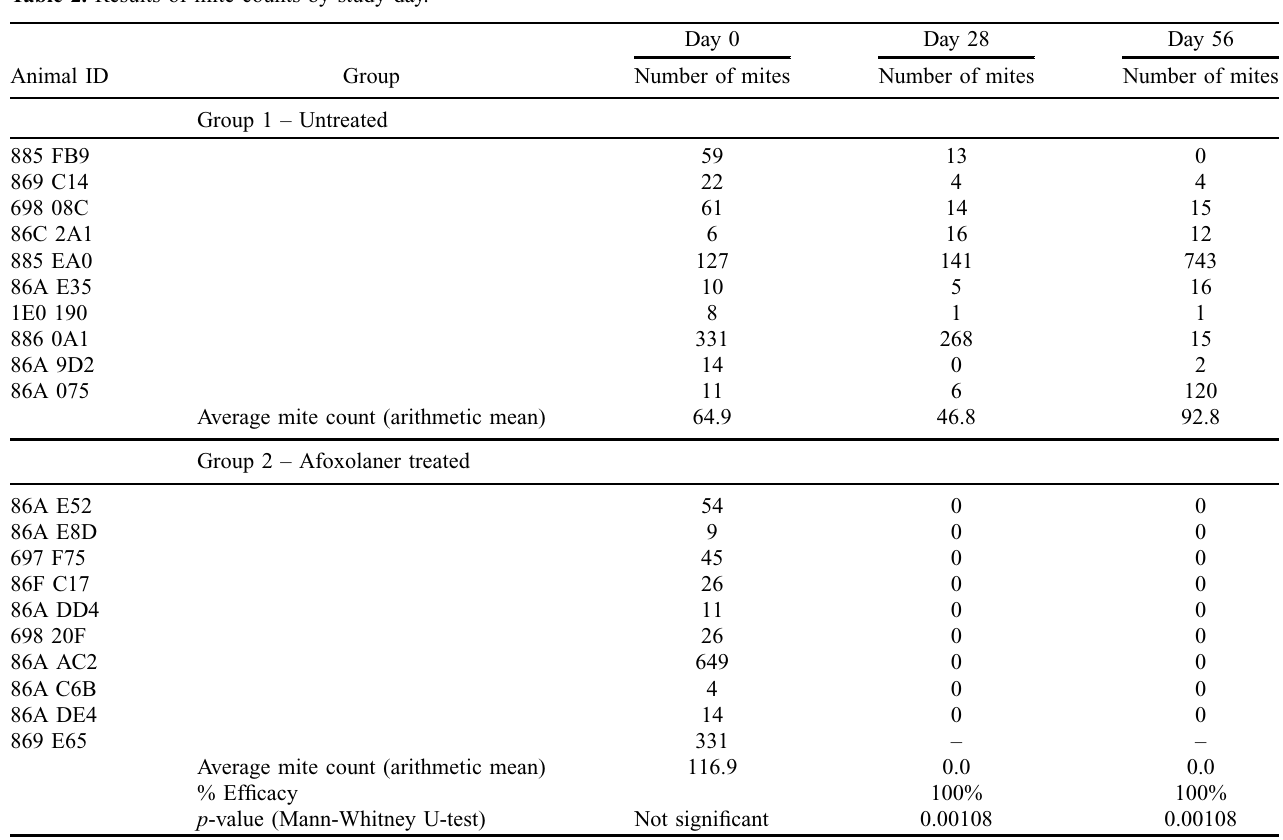
Table 2. Results of mite counts by study day.